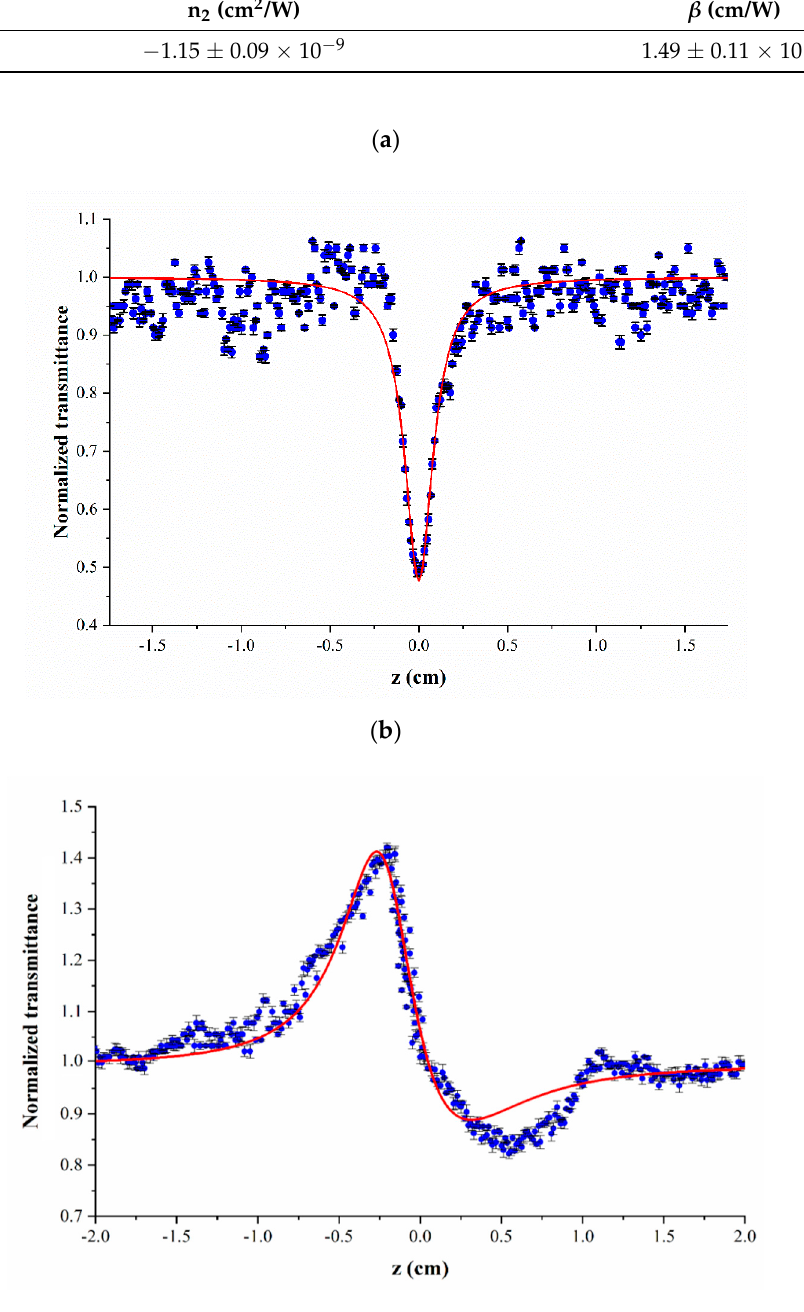
Figure 9. ( a ) open- and ( b ) closed-aperture Z-scan data points of the synthesized CNPs associated with their fitting curves.